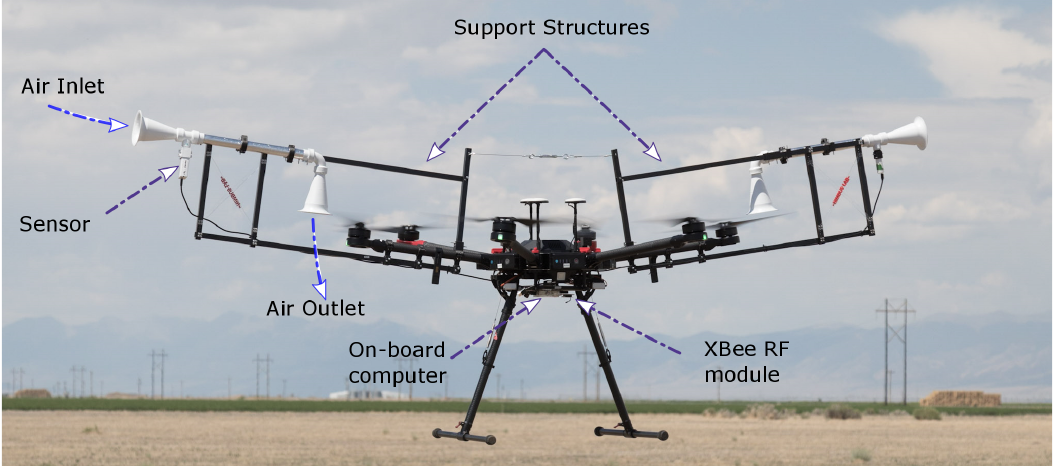
Figure 1. A field trial of sensor housings mounted on a DJI M600 Pro UAS using the square carbon-fiber tube support